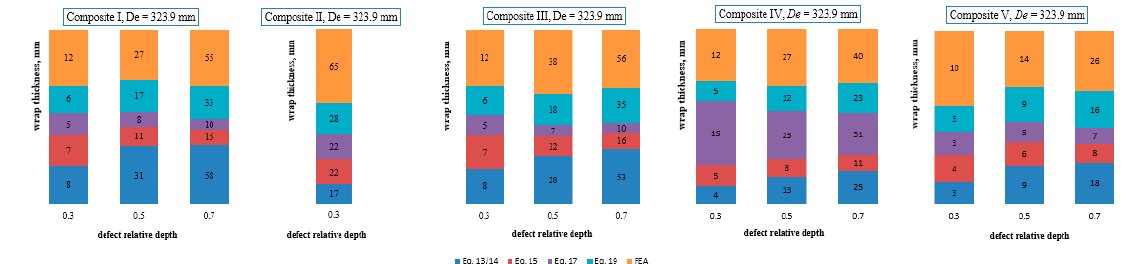
Figure 9. Summary of the results for case study no. 2 (from [21]). Analyzing the results from Figures 8 and 9, it can be noticed that the design method based on Equations (13) and (14) gives the best assessment of the composite thickness (i.e., the values for t cw closest to FEA results) for both type I and III composite repair systems, while Equation (17) gives the best evaluation for the type IV composite. For the case of type II composite, Equation (19) provides the closest t cw values to the FEA results, but these results indicate larger composite thickness values than all analytical design methods. The last statement is also valid for type V composite system, but in this case both Equations (13/14) and (19) provides the closest values of t cw to the FEA results. If comparing only types I to IV of the composite repair systems investigated, type IV (the only one armed with aramid fibers) appears to be the best solution from the point of view of the thickness required, closely followed by type I and III. As type V composite is armed with carbon fibers and therefore it could generate additional corrosion processes in the steel pipe, it has not been included in this final comparison even if it would require the minimum thickness values. In addition to the results detailed in [21], a sensitivity analysis regarding the effect of the defect width on the state of stress in the steel pipe wall and its influence upon the composite wrap design process has been performed. Such FEA has been made for case study no. 1 ( D e = 323.9 mm, steel grade X42), type III composite and a straight defect (for which the actual width equals its circumferential extent, c p ) with d max = 4.75 mm ( d rd = 0.5).